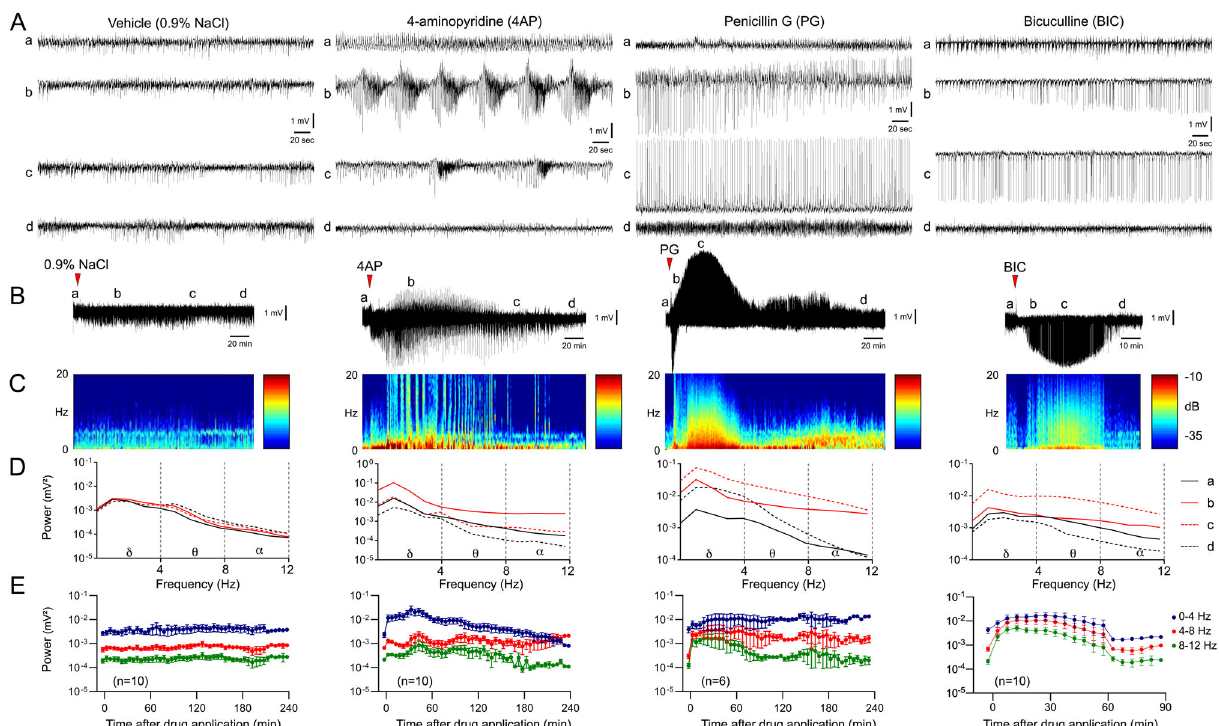
Fig. 1 Characteristics of focal cortical seizures induced by 4AP, PG, and BIC. A Representative ECoG tracings show baseline (a), early and late seizure activity (b, c), and resolution (d) during 4AP, PG, or BIC microseizures, as indicated on the full ECoG timeline ( B ). C Time – frequency-power spectra of the full timeline shown in ( B ) calculated using Thomson ’ s multitaper method. D Power density at the four phases (a – d) computed using FFT. E Average ECoG power time course in δ (0 – 4 Hz), θ (4 – 8 Hz), and α (8 – 12 Hz) frequency bands are shown on a logarithmic scale (±SEM). Sample sizes are indicated on the